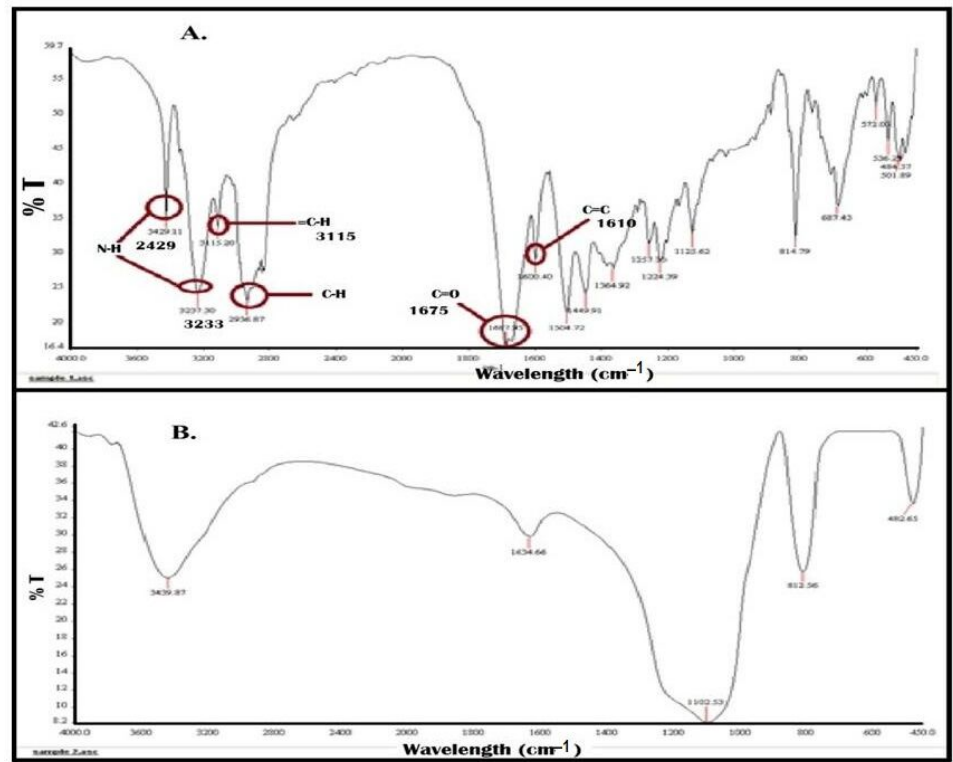
Figure 7. FTIR spectra of ( A ) Pure finasteride and ( B ) Aerosil 200 (blank carrier).